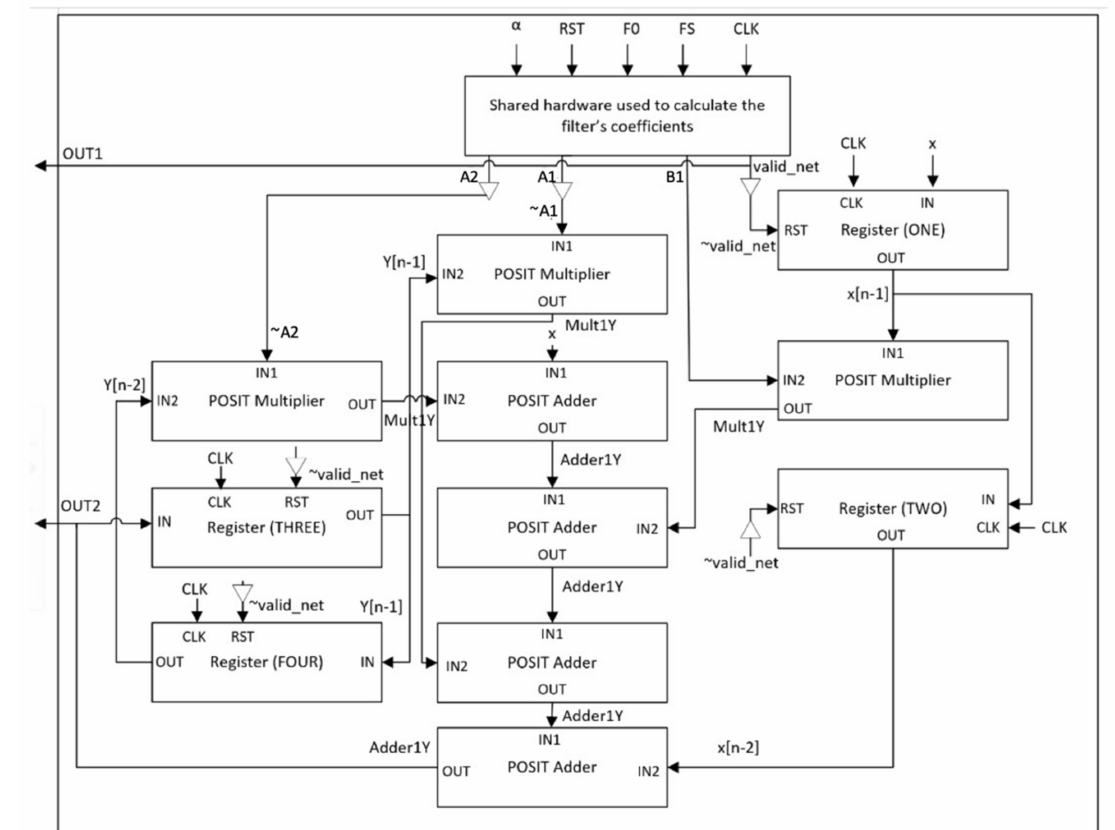
Figure 8. Block diagram of the second-order IIR notch